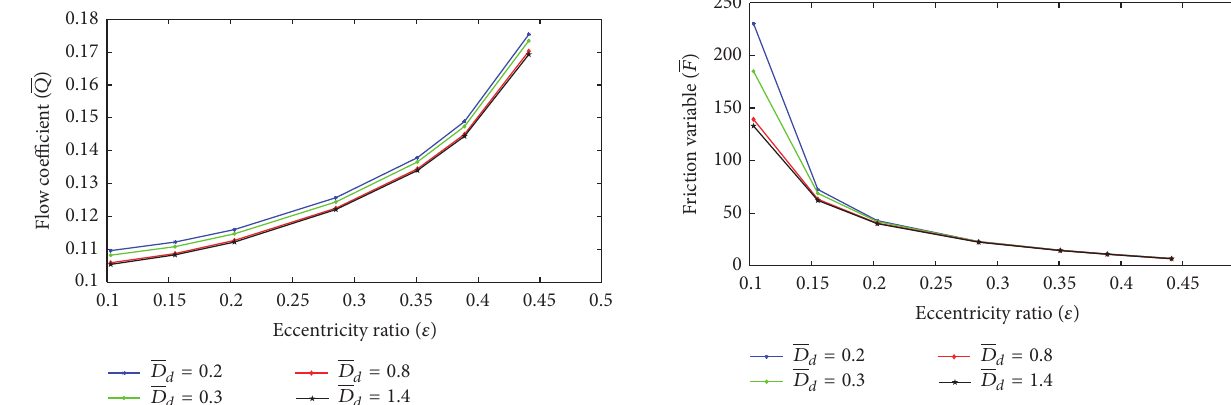
Figure 16: Effect of dam depth ratio on flow coefficient.